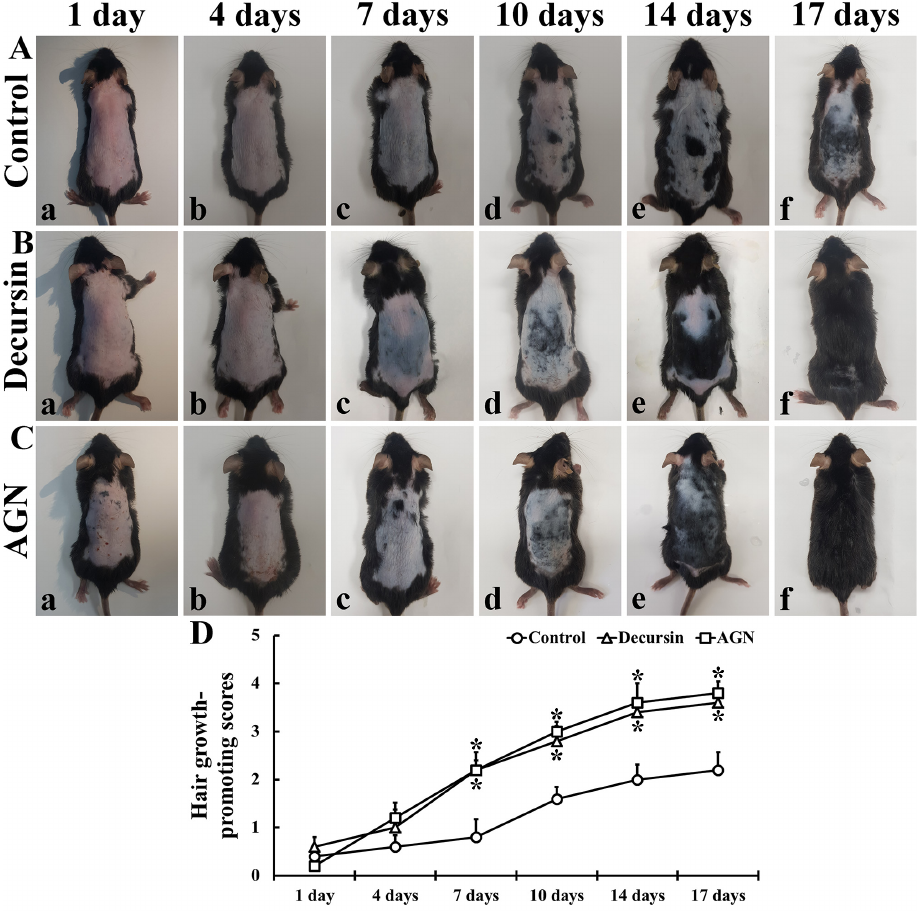
Figure 2. The processes of hair growth in the dorsal skin of the control ( A ), decursin ( B ), and AGN ( C ) groups. Seen in the control group, short hairs are shown at 10 days. However, in the decursin and AGN groups, hairs are shown at 7 days. Occurring by 17 days, complete hair growth is shown in the decursin and AGN groups. ( D ) Hair growth-promoting scores ( n = 10 in each group; * p < 0.05 versus control group). The bars indicate the means ± SEM.